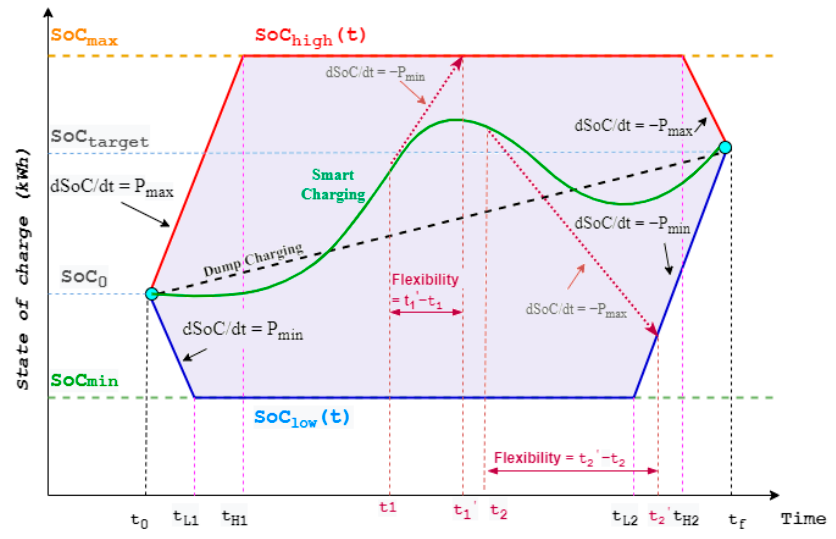
Figure 2. Bounds of the PEV’s stored energy.